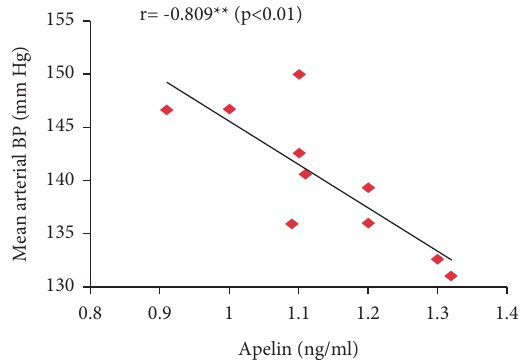
Figure 7: Correlation between serum apelin and mean arterial BP in the PE group.